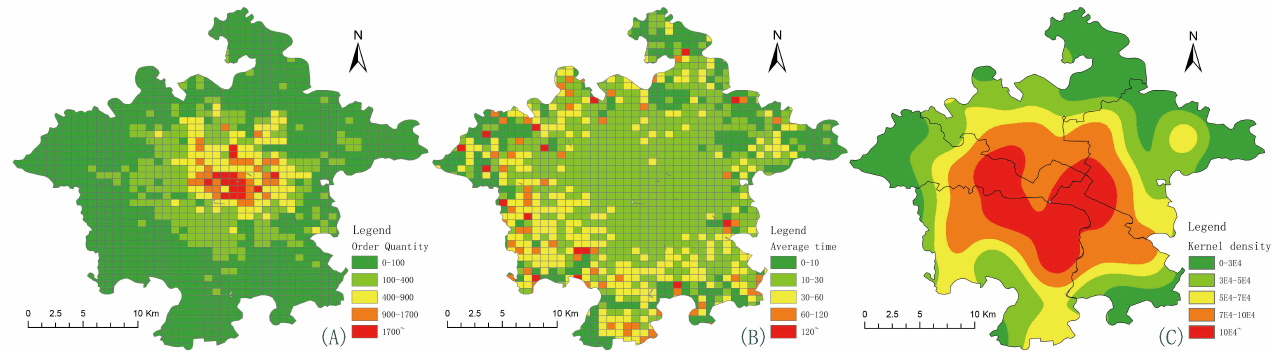
Figure 5. Thermogram of trip frequency. (Subplot ( A ) shows the order density distribution, subplot ( B ) shows the average order length distribution, and subplot ( C ) shows the public transportation density